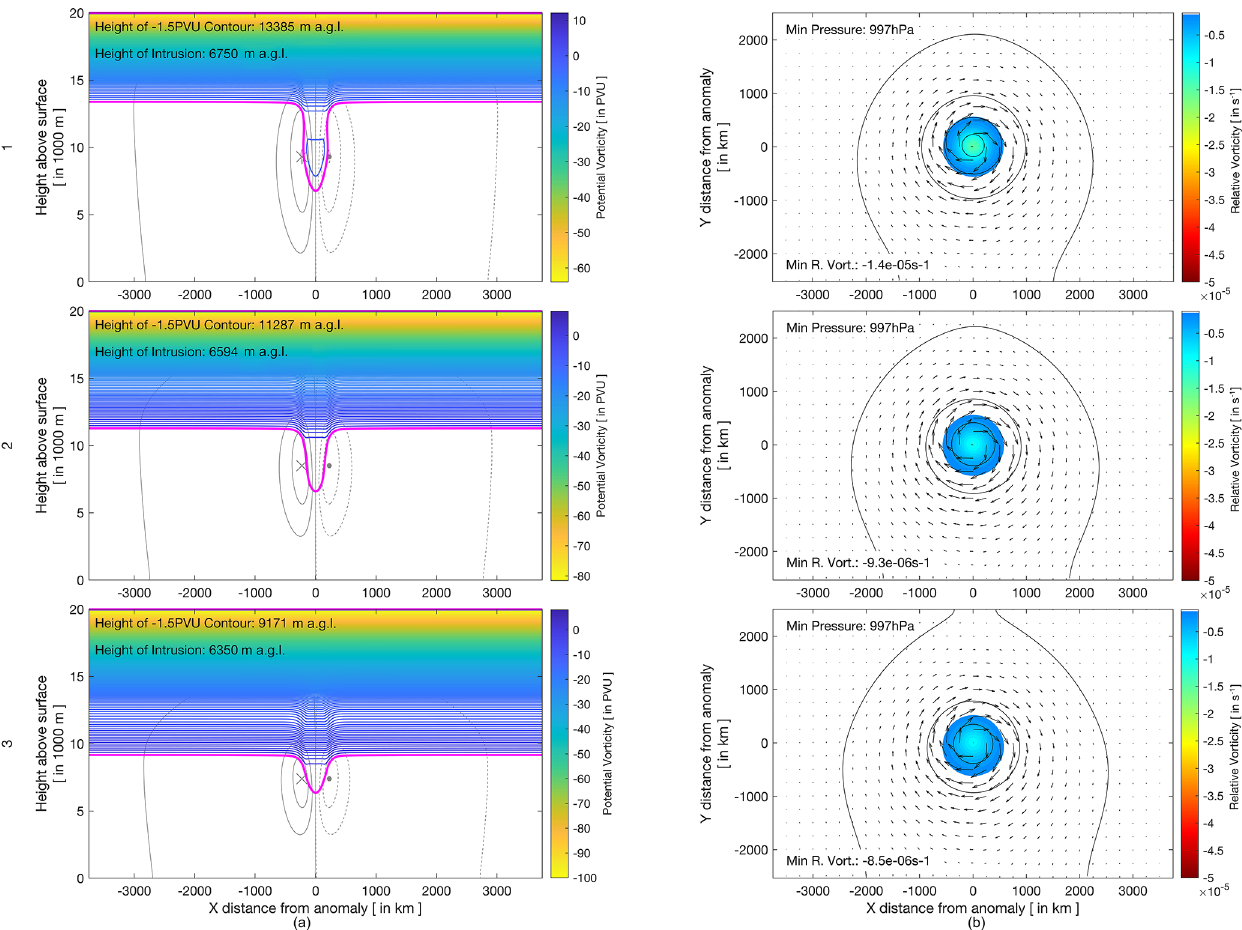
Figure 11. Same as in Fig. 7 but with variable anomaly radial heights such that the heights of the stratospheric intrusions a.g.l. are similar from varying tropopause heights of 15000m (row 1) and 10000m (row 3). Experiment 0 is given in row 2 for ease of